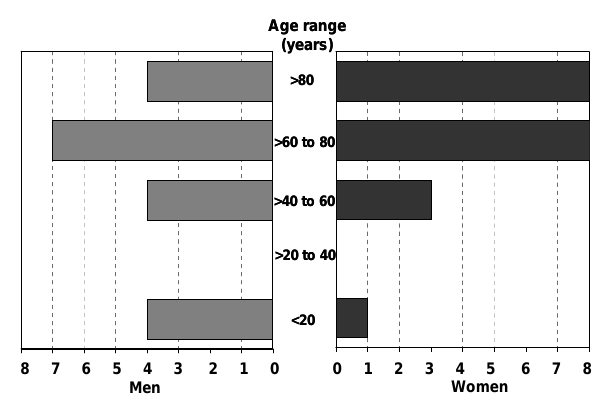
tique et des Etudes Economiques, 2010).